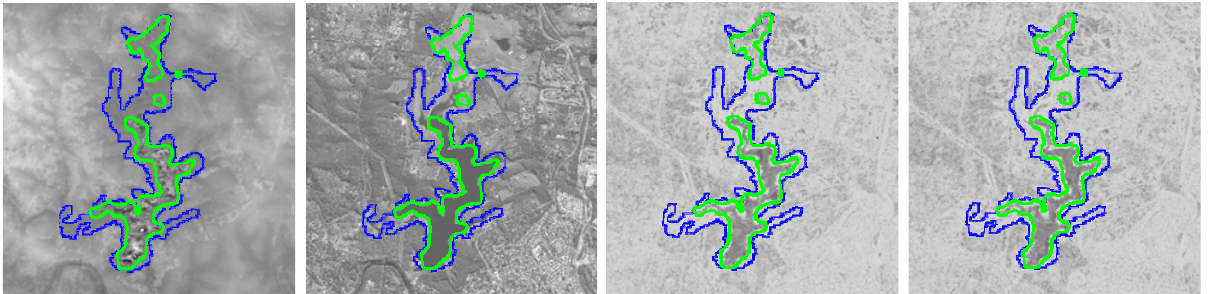
Figure 2. The result of deletion of excessive masks in SWBD. Left to right: DSM gray image, nadir ORI, correlation map between FWD and NDR, correlation map between BWD and NDR. Blue lines depict outline of original SWBD while green lines depict outlines of corrected mask segments.